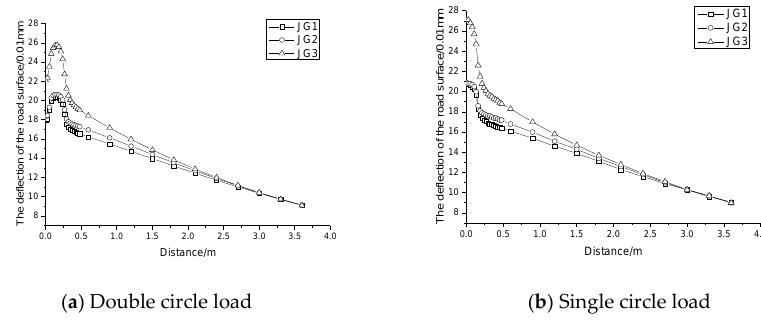
Figure 2. Road deflection of three structures.